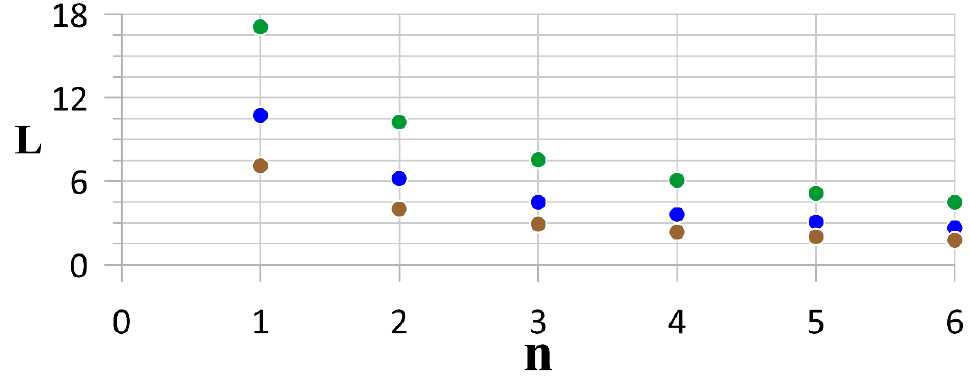
Figure 8. The values of 𝐿 𝑛 (𝑛 = 1, 2,… , 6) for the choreographies of Figure 7 (blue markers), i.e., at 𝛬 21 𝛬 11 ⁄ = 1 4,⁄ and the same at 𝛬 21 𝛬 11 ⁄ = 1 8⁄ (brown markers) and 𝛬 21 𝛬 11 ⁄ = 1 2⁄ (green markers).